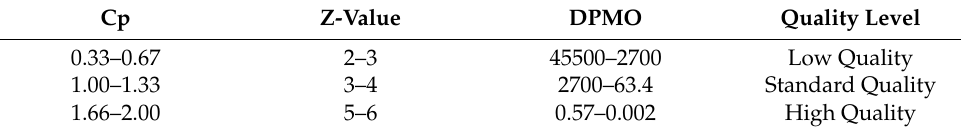
Table 1. Quality